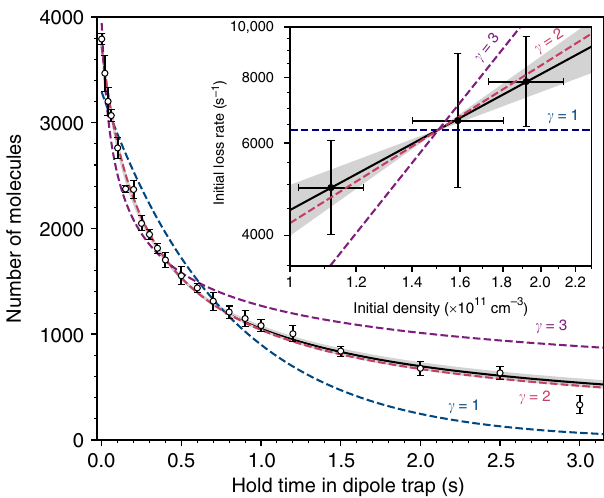
Fig. 1 Loss of ground state molecules. Collisional loss of molecules in j N ¼ 0 ; M N ¼ 0 ; m Rb i ¼ 3 = 2 ; m Cs i ¼ 7 = 2 i with initial temperature of 1.5(1) μ K and peak density 1.9(2) × 10 11 cm − 3 . Each result is the mean of at least fi ve experimental runs, with standard error shown. The solid black line shows a fi t to the coupled rate equations given in Eq. (2) with 1 standard deviation ( σ ) uncertainty in γ shaded. The dashed lines show fi ts to the data with fi xed γ = 1, 2 and 3 corresponding to one-, two- and three-body loss, respectively. Inset: Density dependence of the initial loss rate on a log – log scale. The vertical error bars show the 1 σ uncertainty in the linear gradient fi tted to the fi rst 200 ms of each loss measurement, and the horizontal error bars show the 1 σ uncertainty in the density derived from the uncertainties in the starting temperature, number and trap frequencies. The solid line is a linear fi t, with 1 σ uncertainty in the gradient shaded, while the dashed lines indicate the expectations for one-, two- and three-body loss with a linear function to extract the gradient. The variation of the initial loss rate as a function of initial density is shown inset in Fig. 1 on a log – log scale. A linear fi t to Fig. 1 yields a gradient of 0.9(3), again indicating a second-order process.